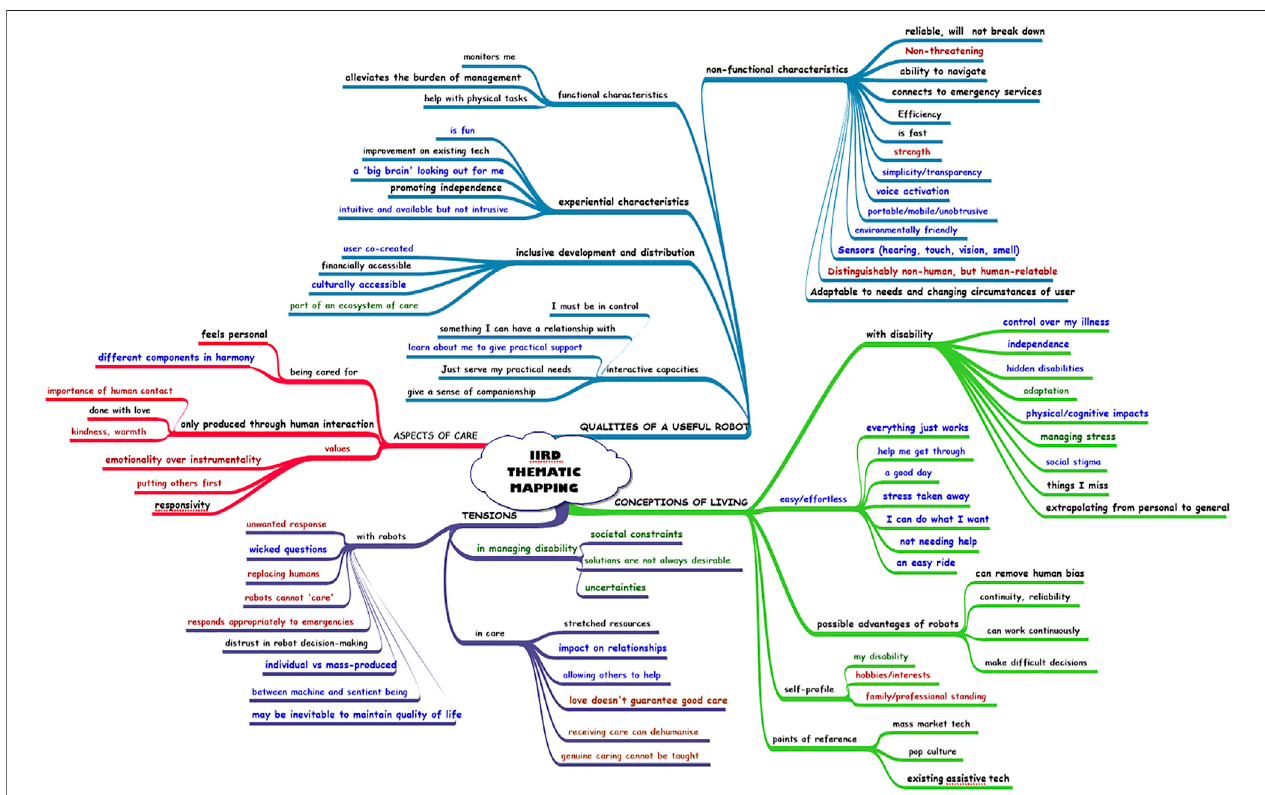
FIGURE 1 | IIRD Thematic